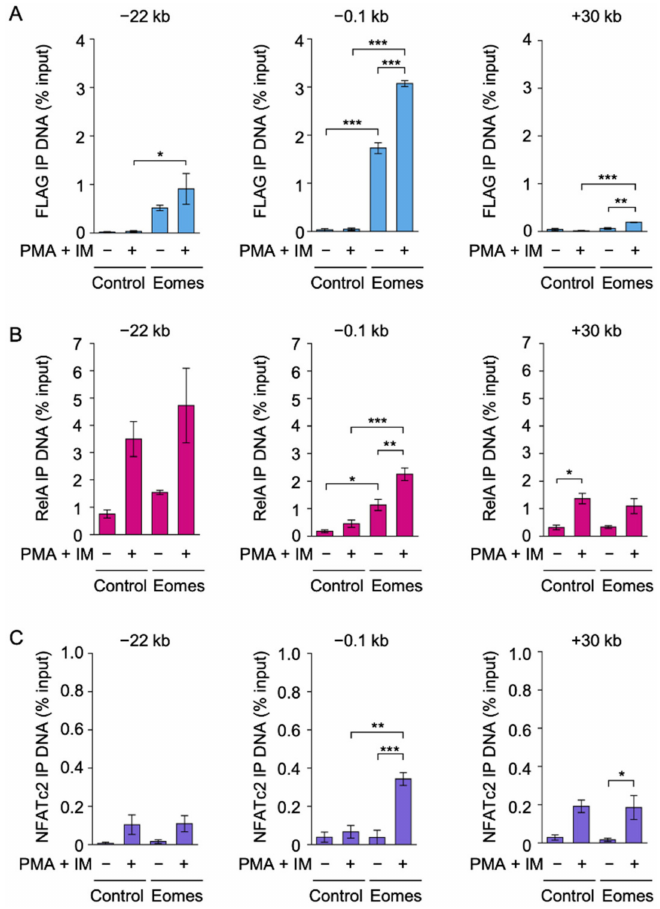
Figure 2. Binding of FLAG-Eomes, RelA, and NFATc2 to the IFN- γ promoter, CNS − 22, and CNS+30 in EL4 transfectants. ( A – C ) The Control #2 EL4 transfectant (Control) and Eomes #2 EL4 transfectant (Eomes) were treated with (+) or without ( − ) PMA (10 nM) and IM (1 µ M) for 2 h. ChIP assays were performed for FLAG-Eomes ( A ), RelA ( B ), and NFATc2 ( C ). Quantitative PCR was used to measure the amounts of fifteen different DNA regions. The IFN- γ promoter ( − 0.1 kb), CNS − 22, and CNS+30 are shown in this figure. Other regions for FLAG-Eomes, RelA, and NFATc2 are shown in Figures S2–S4, respectively. Immunoprecipitated (IP) DNA (% input) is shown as the mean ± S.E. of three independent experiments. * p < 0.05, ** p < 0.01, and *** p <